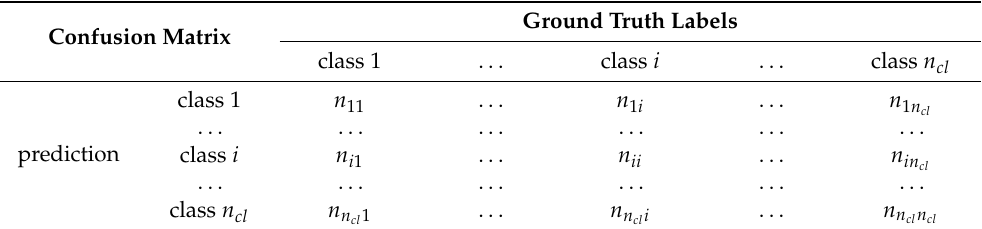
Table 3. Confusion